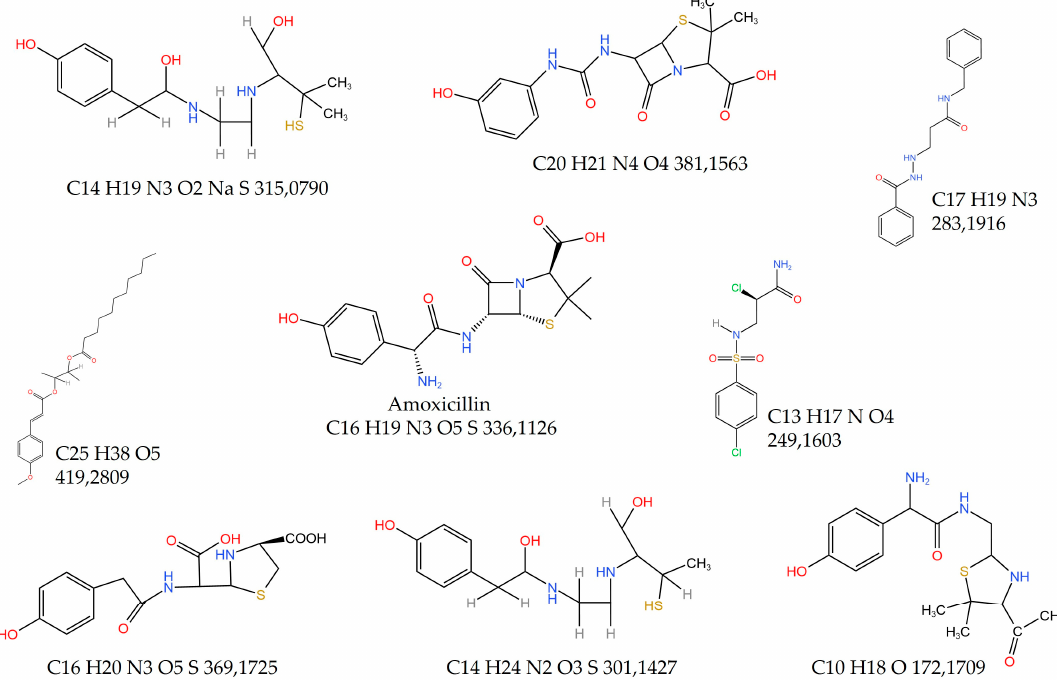
Figure 5. Structures of the identified compounds after 120 min of solar photocatalysis of amoxicillin in CPC reactor over TiO 2 –CNT@PETG static mixer.